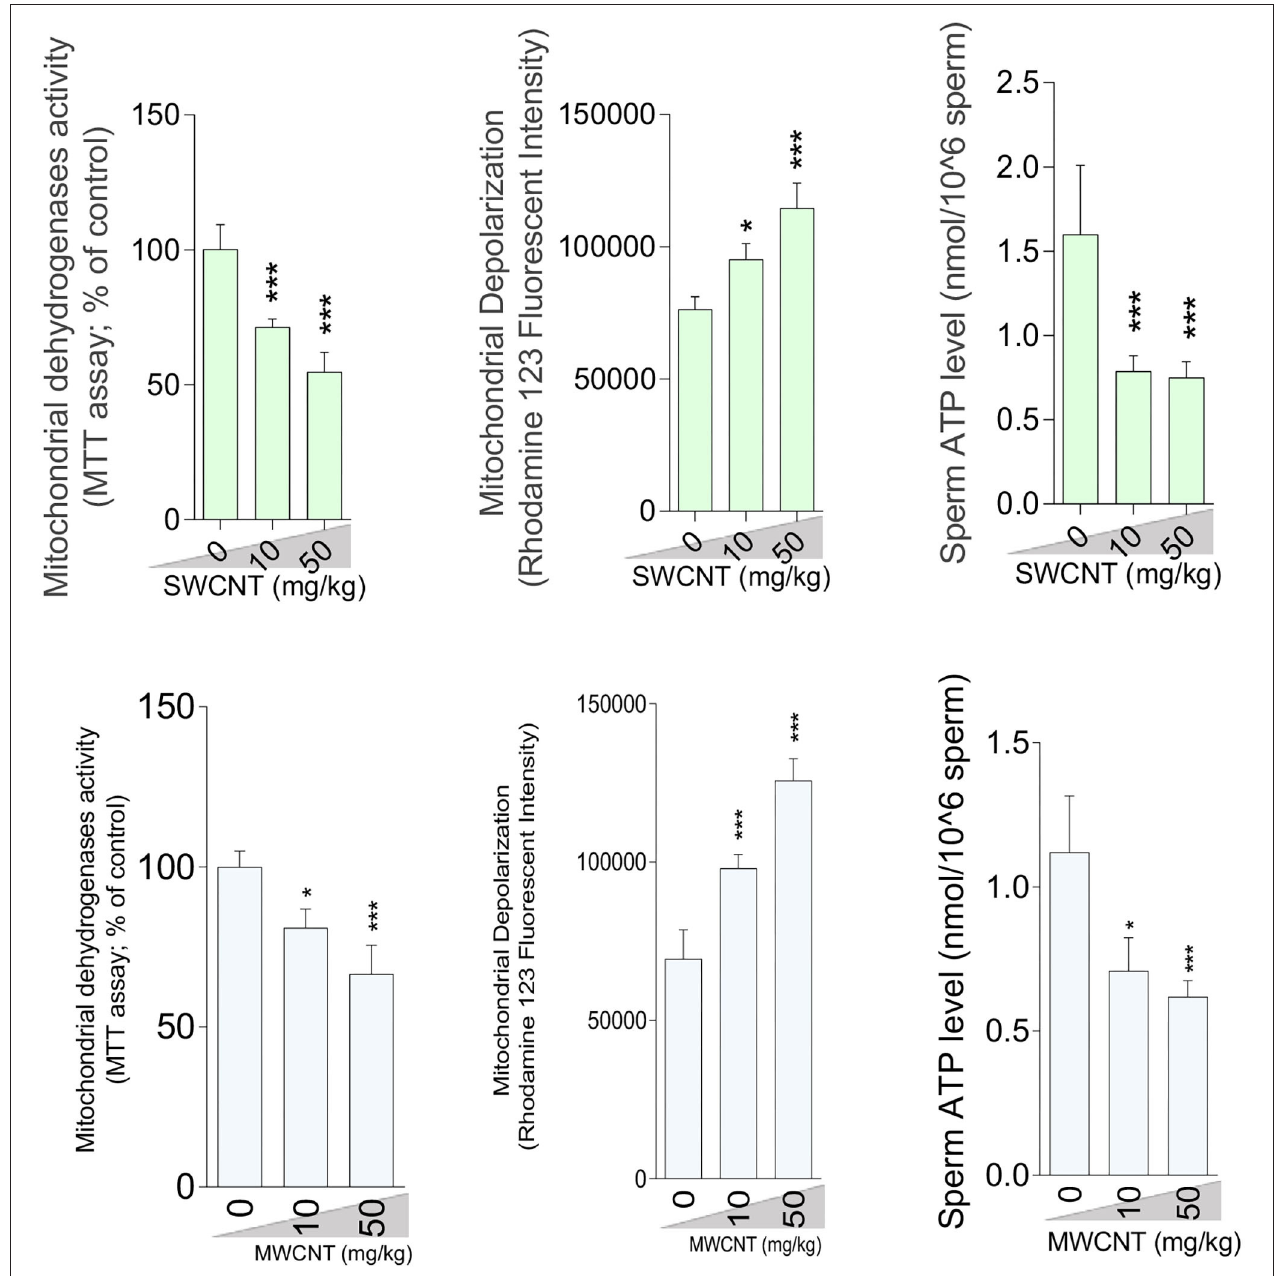
FIGURE 9 | Sperm mitochondrial impairment in carbon nanotubes-exposed animals. (mean ± SEM, n = 6). Asterisks indicate significantly different from the control (0 ppm) group (* P < 0.05, *** P < 0.001).